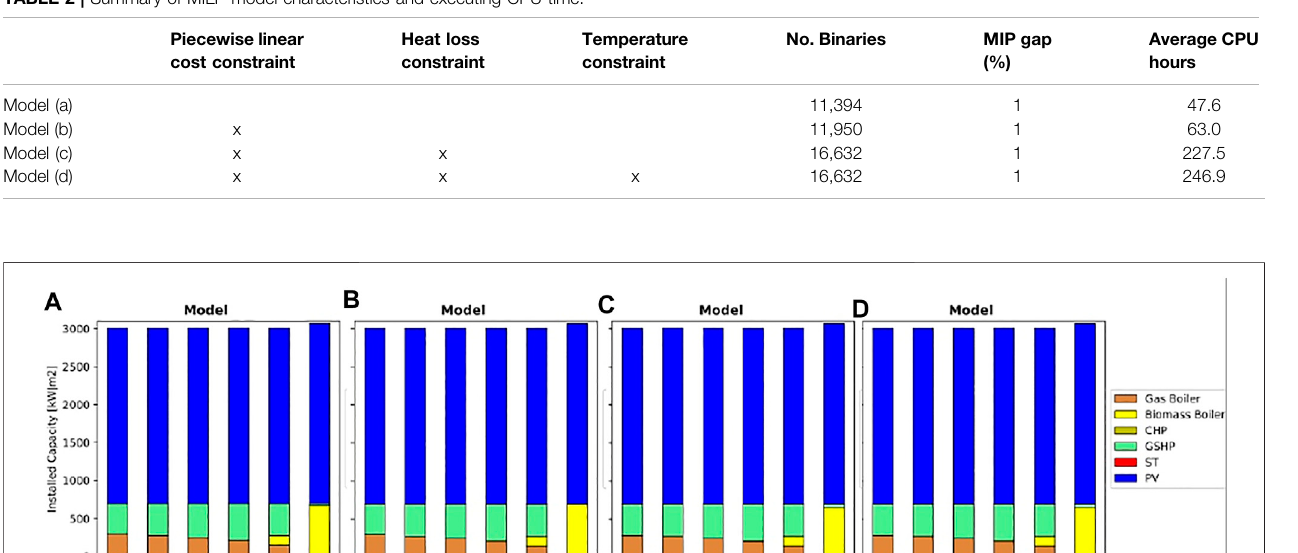
TABLE 2 | Summary of MILP model characteristics and executing CPU time.